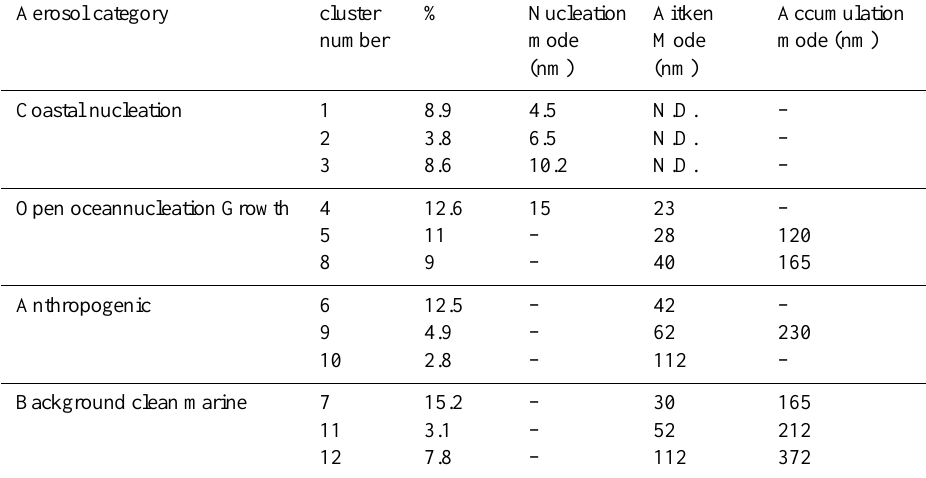
Open oceannucleation